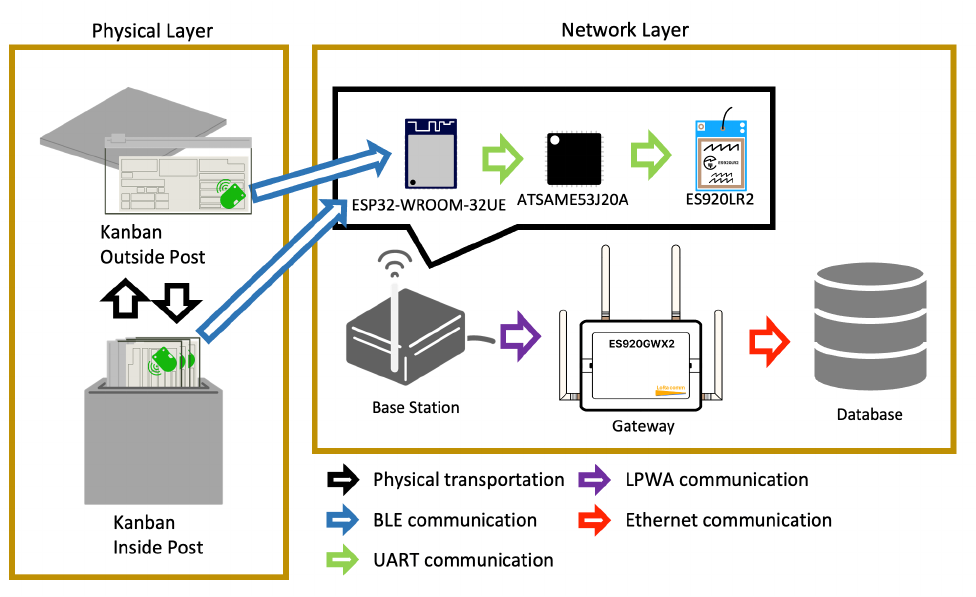
Figure 1. System Architecture overview of the proposal.